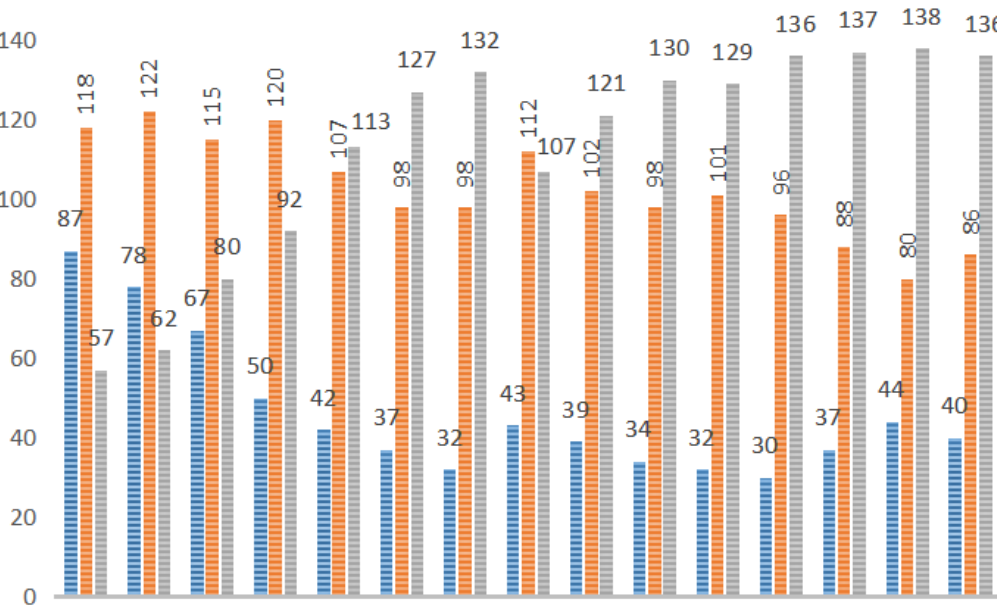
Figure 5. The number of cities in different stages of industry size from 2004 to 2018.